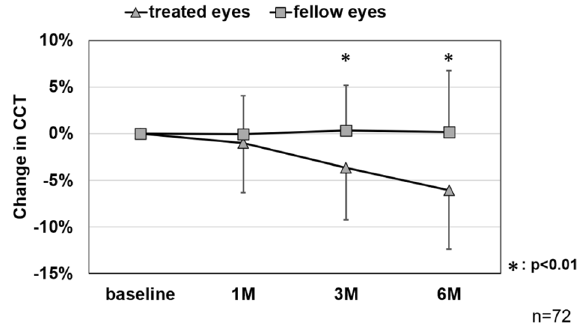
Figure 5. Changes in central choroidal thickness (CCT) between the treated and fellow eye mean CCT at baseline was 351 ± 97 μm in treated eyes and 312 ± 92 μm in fellow eyes with a significant difference ( p < 0.05). Mean change in CCT was − 1.0 ± 5.3% in treated eyes and − 0.1 ± 4.2% in fellow eyes after 1 month, − 3.6 ± 5.6% and 0.4 ± 4.8% after 3 months, and − 6.0 ± 6.3% and 0.2 ± 6.6% after 6 months, showing a significant difference after 3 and 6 months (1 month, p = 0.73; 3 months, p < 0.01; 6 months, p < 0.01).